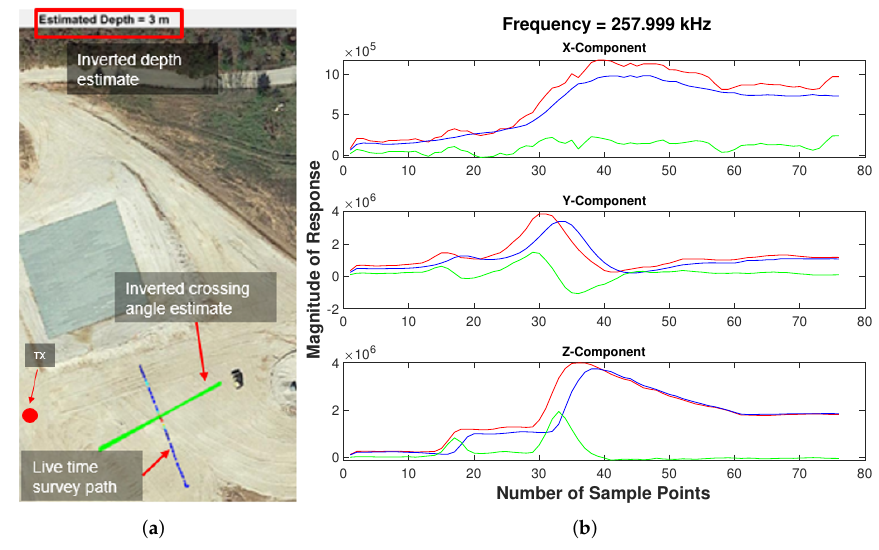
Figure 16. Dry, grass-free environment testing. ( a ) Overhead view of survey site. ( b ) Results from vertical magnetic dipole TX—red and blue lines plot the response from the front and back gradiometer receivers, respectively. The green line plots the magnitude of the front RX subtracted by the magnitude of the back RX.